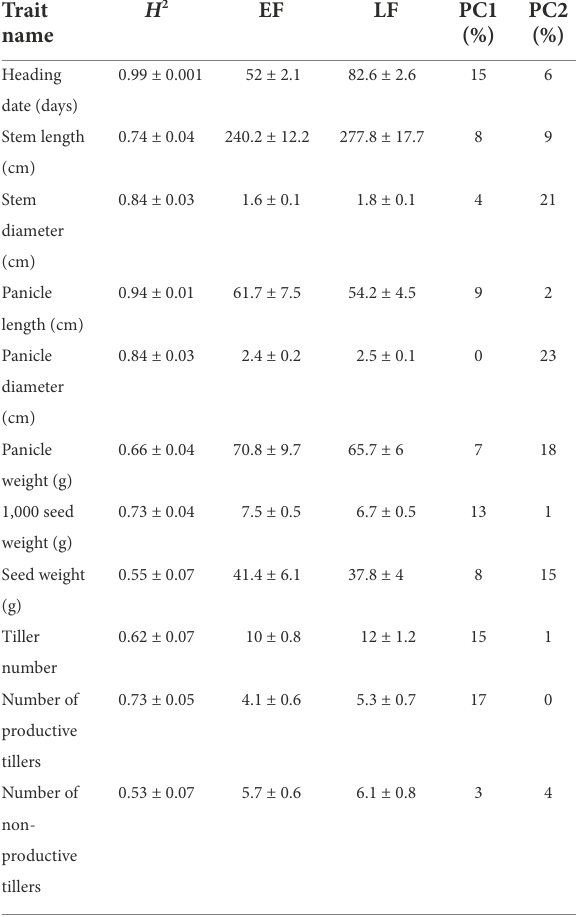
TABLE 1 Phenotypic diversity Heritability estimates (±SD) and mean values of phenotype diversity (±SD) in early- (EF) and late-flowering (LF) pearl millet accessions are